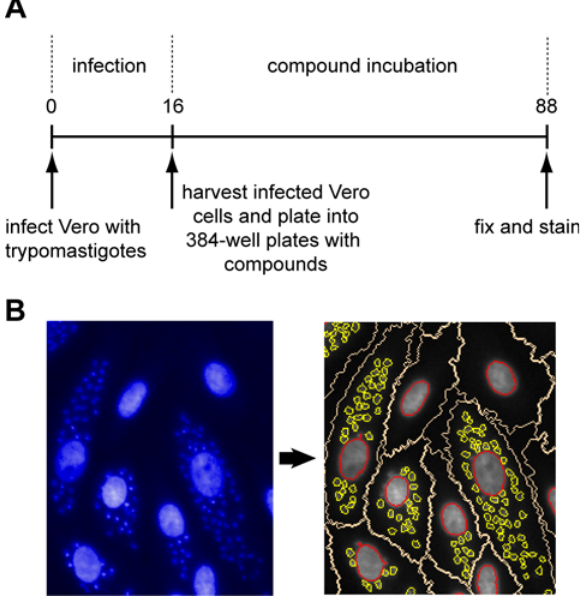
Fig 1. T . cruzi primary screening assay. Panel A. Schematic outline of the primary screening assay. Numbers are time in hours. Panel B. Image acquisition and analysis. Left-hand side shows an image as obtained from the high-content microscope. The large structures are the nuclei of the host cells and the small punctate structures are the nuclei of the amastigotes. The right-hand panel shows the segmentation carried out by the image analysis algorithm. The nuclei are delineated in red, the Vero cell cytoplasm in white and the amastigotes in yellow.